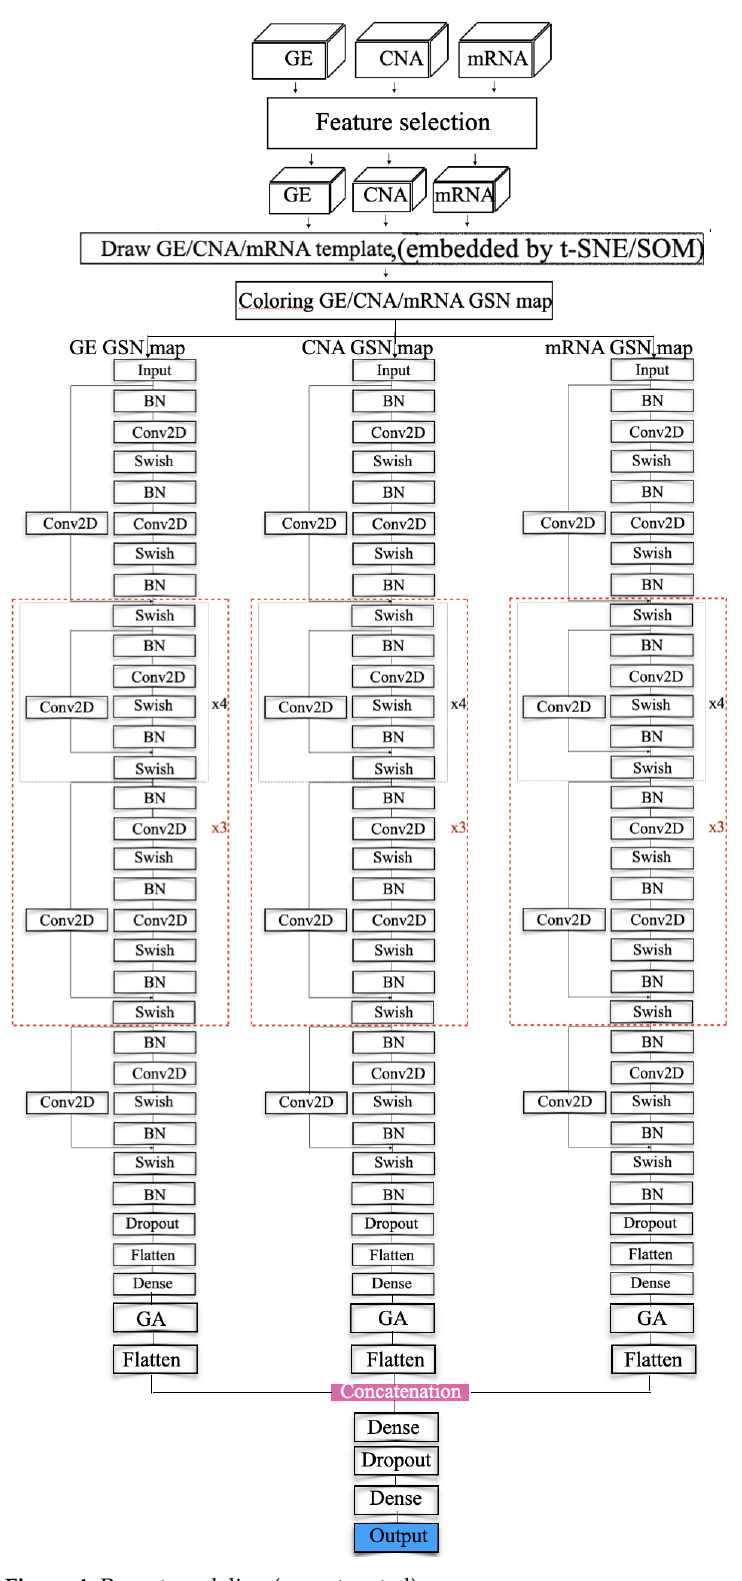
Figure 4. Resnet modeling